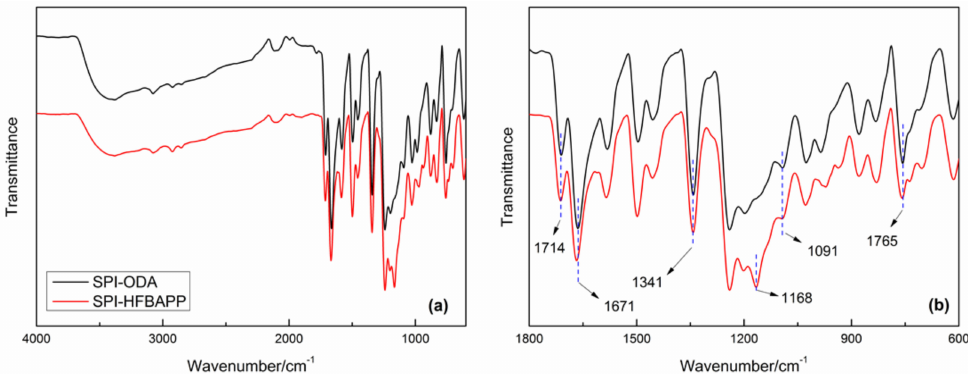
Figure 1. FT-IR of SPI-ODA and SPI-HFBAPP. ( a ) Wavenumber from 500 cm − 1 to 4000 cm − 1 ; ( b ) wavenumber from 600 cm − 1 to 1800 cm − 1 .